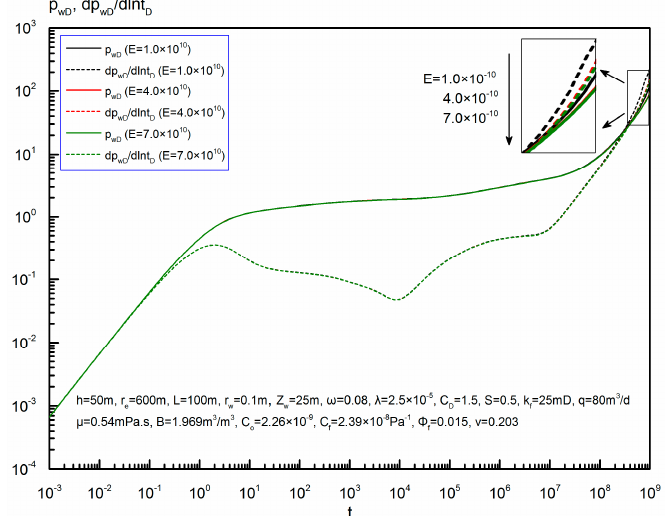
Figure 14. Effect of Young’s modulus ( E ) on the transient pressure behavior of H519 in North Truva field.